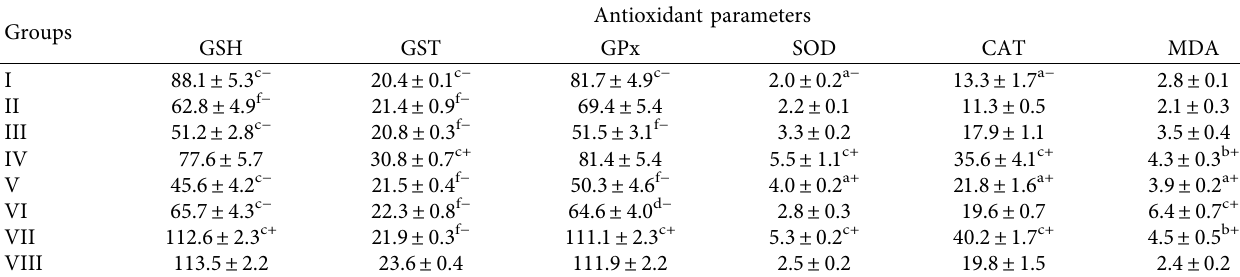
Table 8: Antioxidant activities of 50–400 mg/kg/day of CVE in DOX-treated rat cardiac tissue. Groups